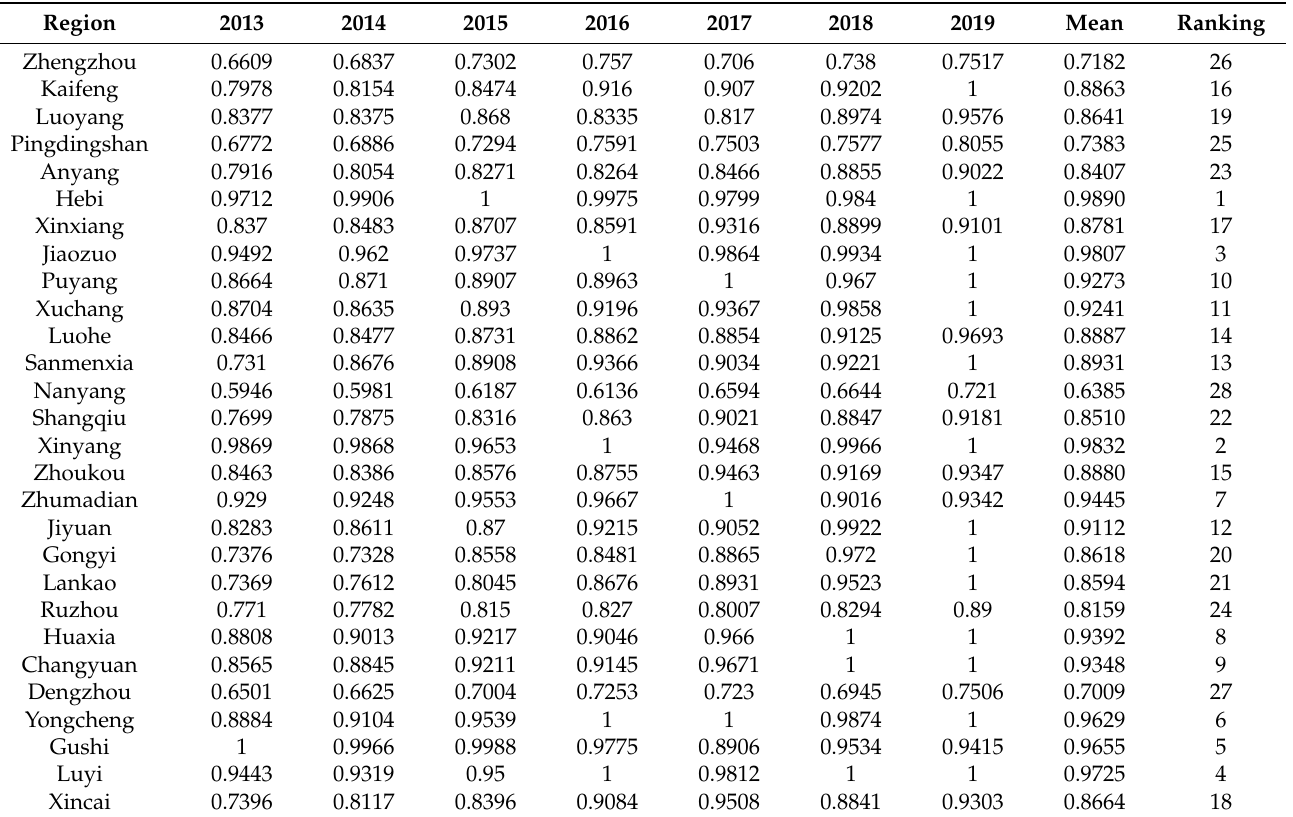
Table 2. Efficiency of the agricultural circular economy in various cities (counties) of Henan Province in 2013–2019 under the CCR model.